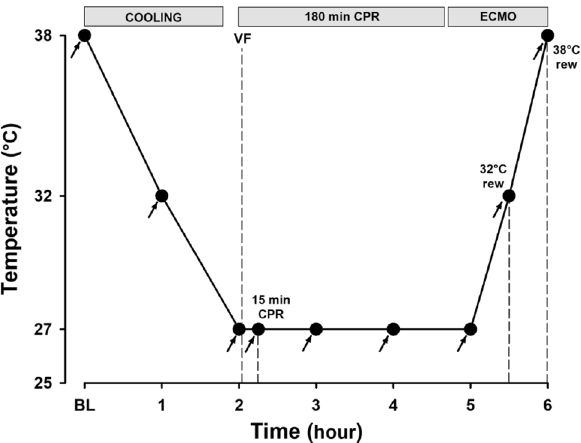
Figure 4. Experimental protocol. Arrows depict time points for hemodynamic measurements, blood sampling, and microsphere